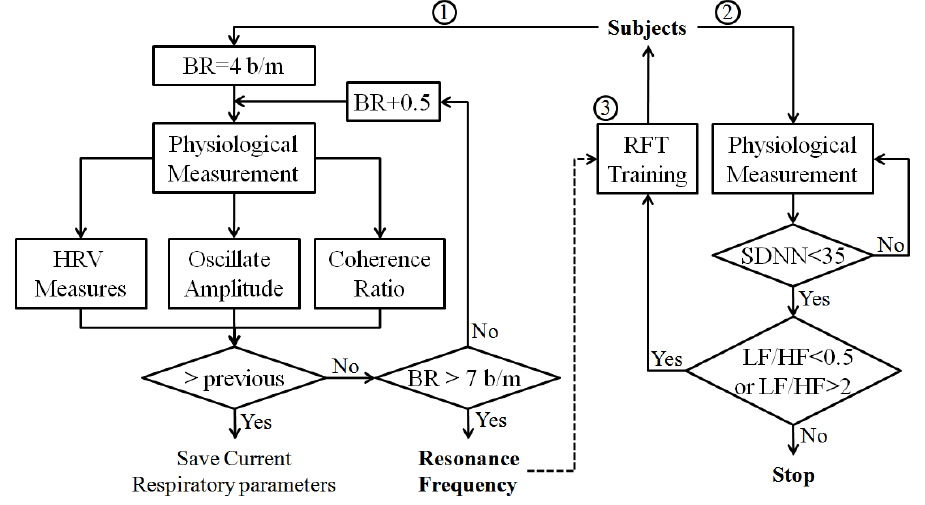
Figure 8. The flowchart of biofeedback algorithm; Step 1, find individual’s resonant respiratory frequency; Step 2, stress assessment; Step 3, RFT-based respiration